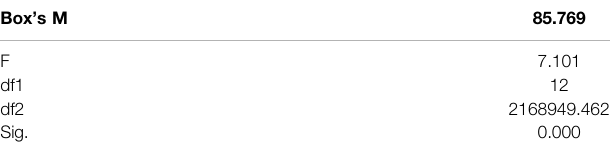
TABLE 4 | Box ’ s test of equality of covariance